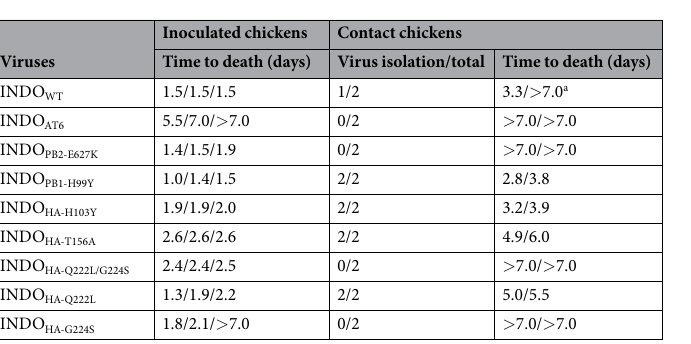
Table 1. Mean time to death of inoculated and contact chickens. a > 7.0 means that animals did not get infected and were euthanized as the end of the